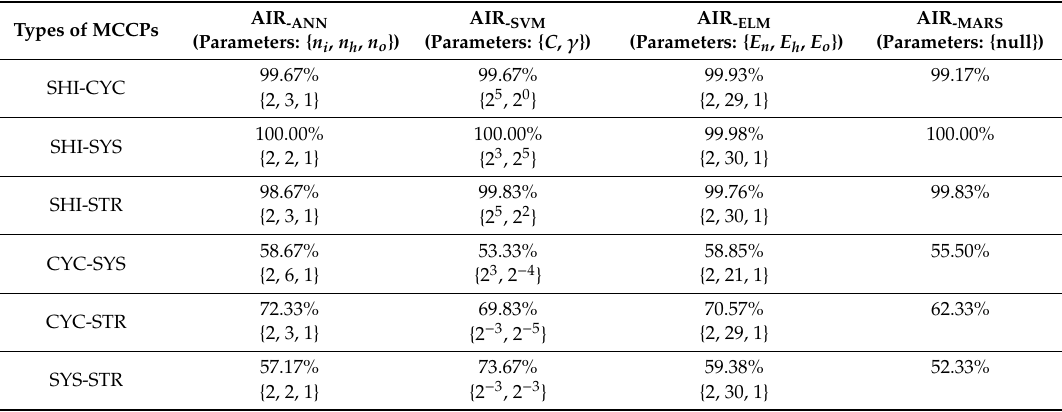
Table 3. Results of MCCP recognition for two process outputs (second scheme: with the use of EPC). Types of